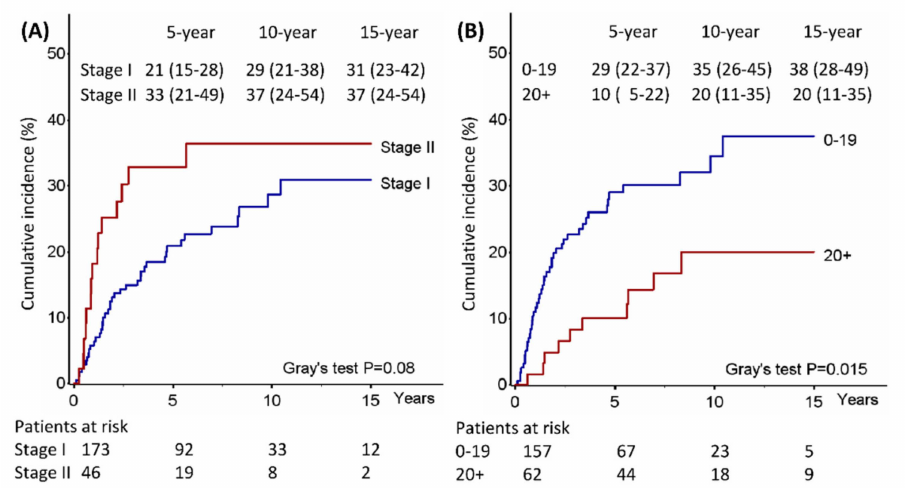
Figure 4. Cumulative incidence of relapse by clinical stage ( A ) or number of resected nodes ( B